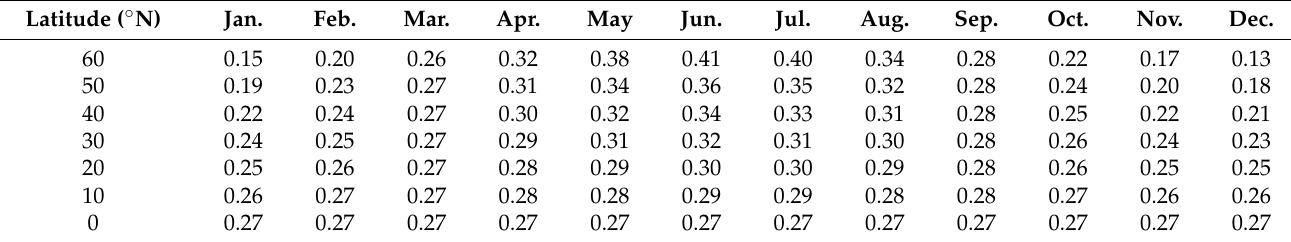
Table 1. The factor of sunshine hours P with respect to latitude and month (Ponce, 1989) [27]. Latitude ( ◦ N)